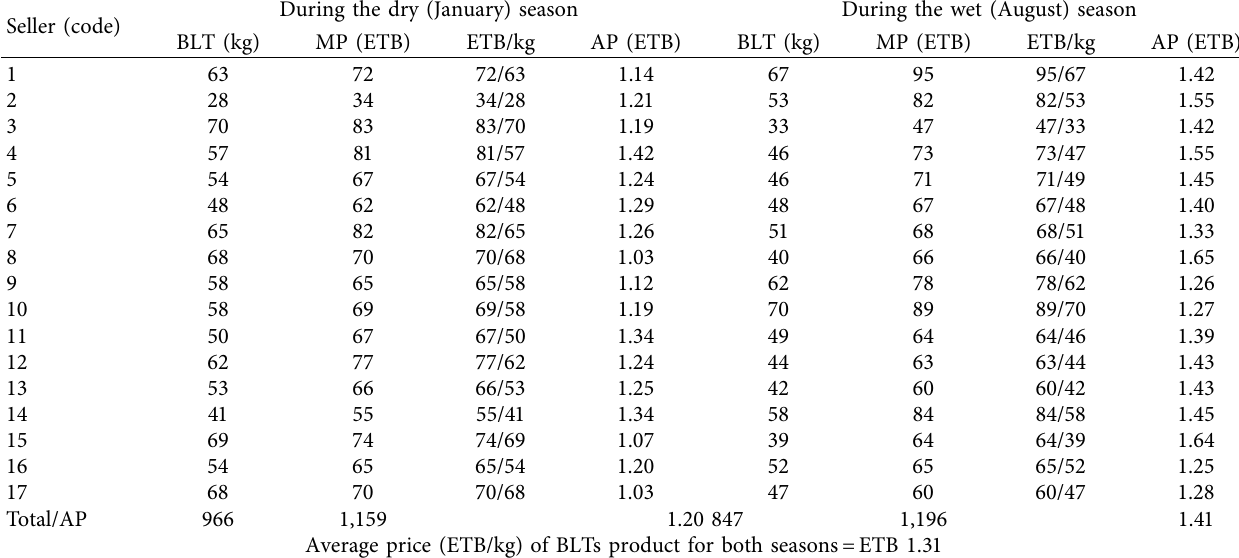
Table 4: Physical value/bundles/kg of litter (BLTs) and its corresponding monetary market price (MP) and average price (AP)/ETB/kg. During the dry (January) season Seller (code)